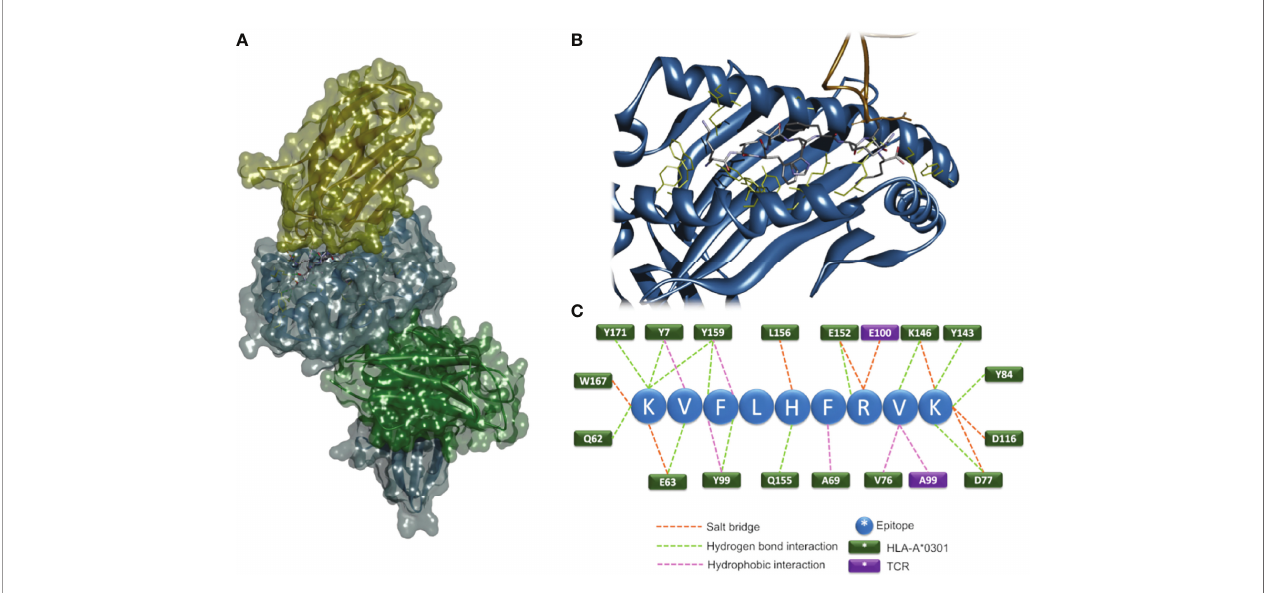
FIGURE 5 | In-silico 3D modeling. Molecular modeling of the TCRBV/HLA-class I/epitope complex. Overall 3D structure of the quaternary complex (A) . The backbone structures of TCRBV21 (yellow), HLA-A3*01 a -chain (blue), and b 2-microglobulin (green) are displayed in ribbon and solvent-accessible surface representations. The epitope residues are in stick representation color-coded by atom types. A zoom view of the contact interface showing the residues important for the stabilization of the complex (B) . Sketch of the predicted interactions at the interface (C) ; epitope residues are shown as blue circles, and HLA and TCR residues as green and violet rectangles, respectively.